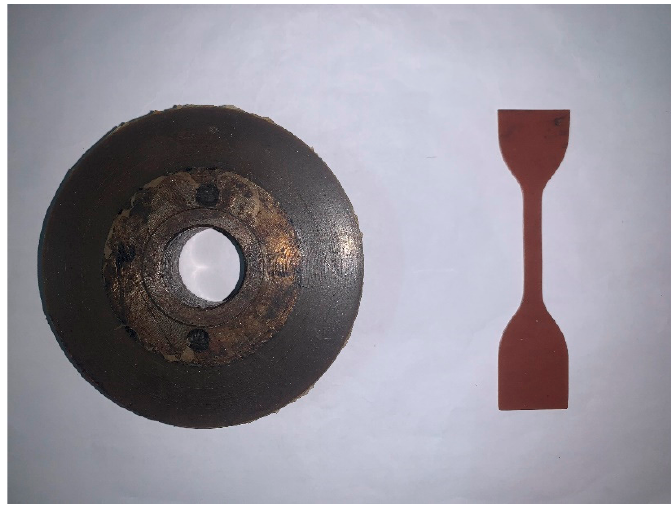
Figure 1. Solid rubber tires ( left ) and dumbbell rubber specimen ( right